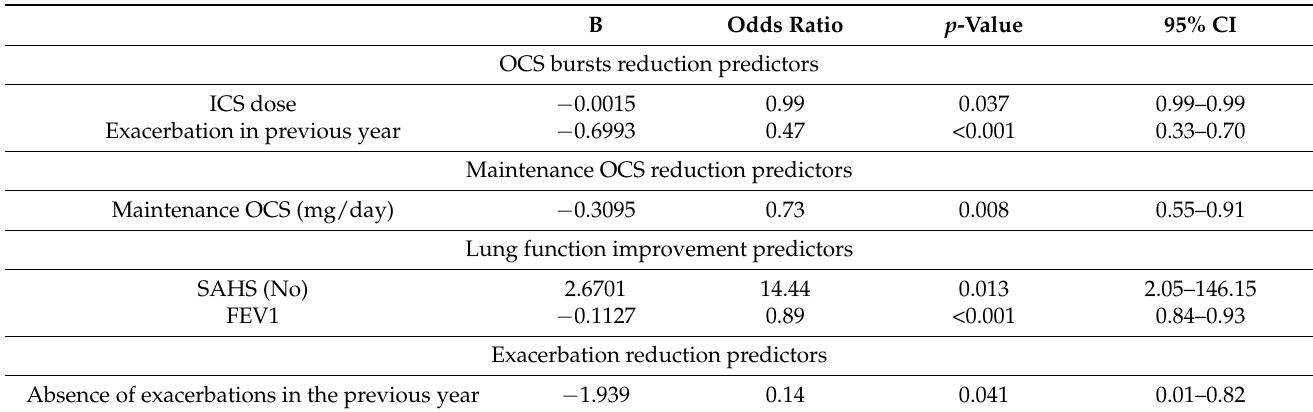
Table 6. Predictors of response after 12 months of treatment with mepolizumab in patients with severe uncontrolled asthma (multivariate